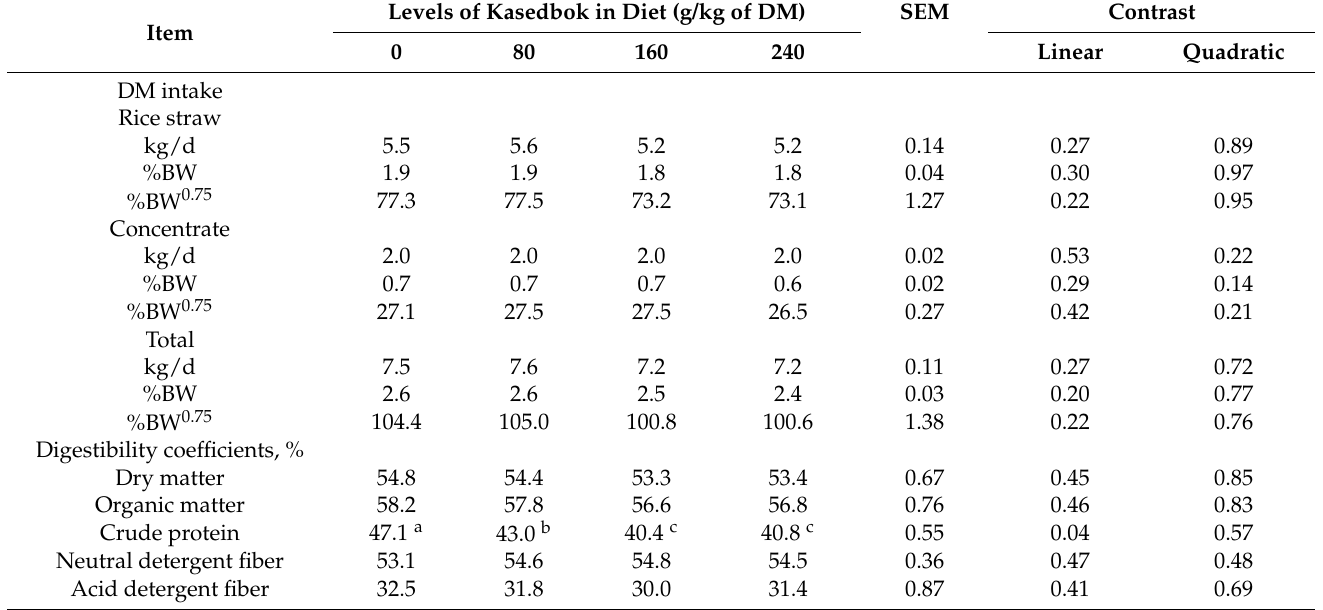
Table 2. Feed Intake and digestibility of Thai native beef